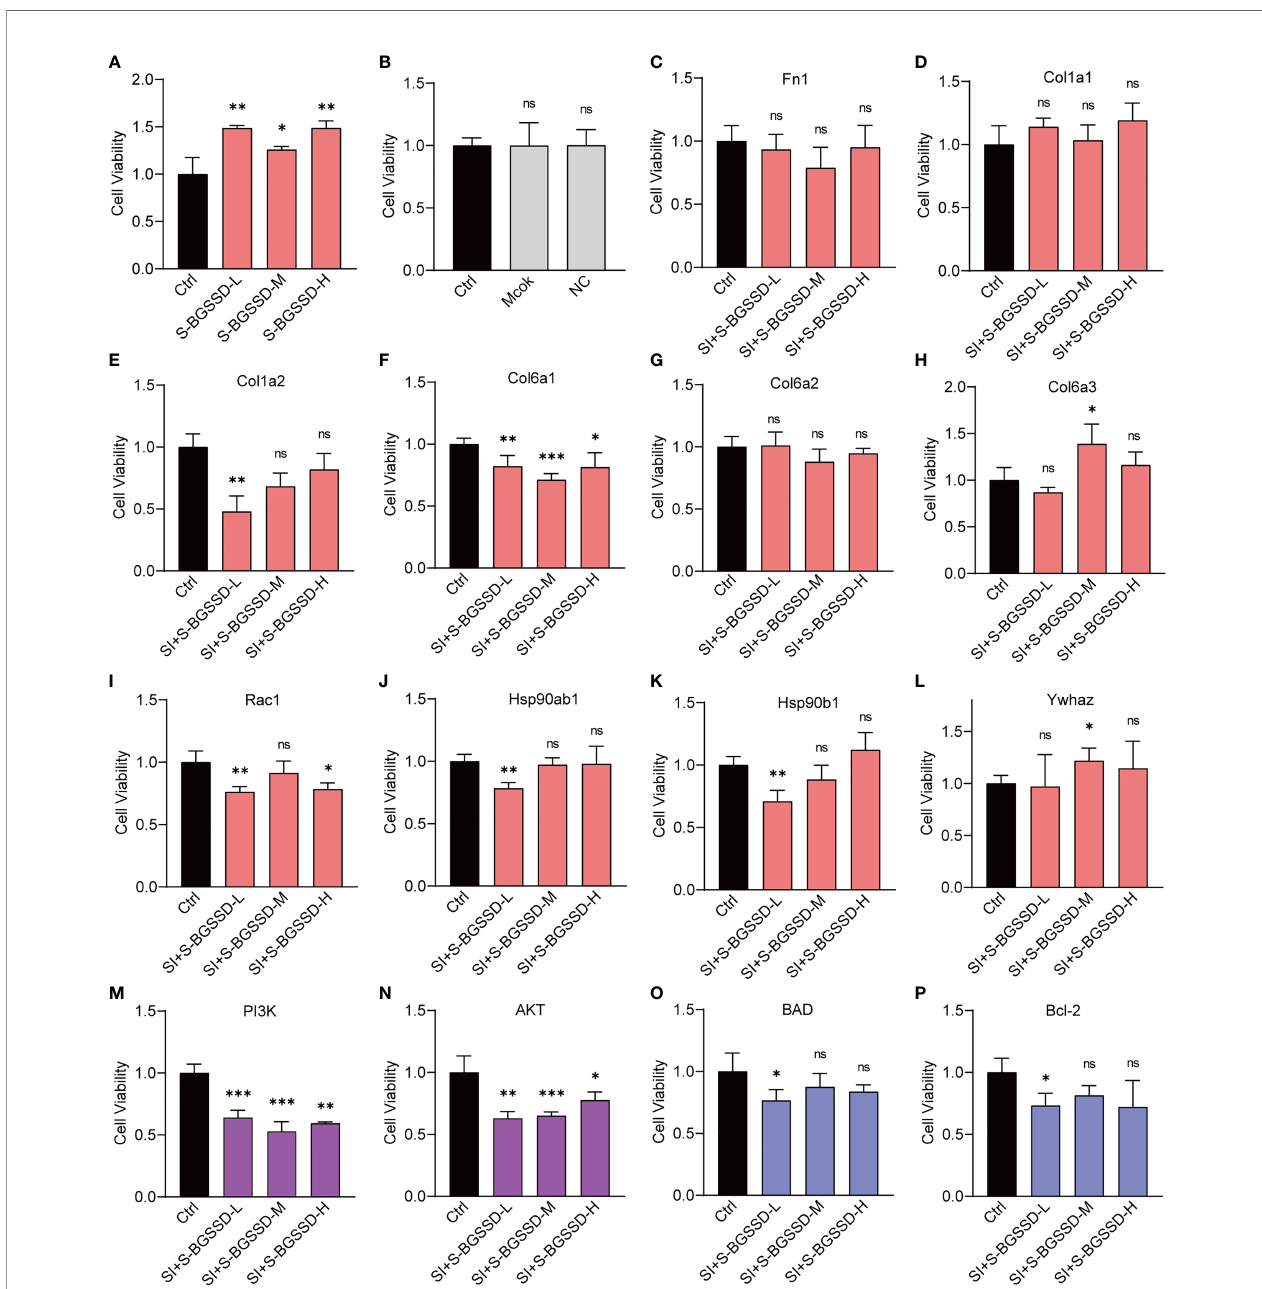
FIGURE 5 | RNA interference to verify the effects of targeting proteins of the PI3K-AKT pathway on the ef fi cacy of BGSSD. (A) BGSSD could promote the proliferation of MC3T3-E1 cells. (B) The solvent (Mock) and negative control (NC) of siRNA almost had no effect on the viability of MC3T3-E1 cells. (C – L) Knockdown of each of the ten targeted proteins (Fn1, Col1a1, Col1a2, Col6a1, Col6a2, Col6a3, Rac1, Hsp90ab1, Hsp90b1, and Ywhaz, except the Col6a3 and Ywhaz in the S- BGSSD-M group) by siRNA abolished the proliferation-promoting effect to various extents of BGSSD in MC3T3-E1 cells. (M – P) Knockdown of the proteins of PI3K- AKT and its downstream pathway, named PI3K, AKT, BAD, and Bcl-2, revoked the pro-proliferation effect of BGSSD. The pink columns represent the outcomes of targets obtained by quantitative proteomics. The purple columns refer to the proteins in the PI3K-AKT signaling pathway. The blue are proteins in the downstream pathway. Asterisks denote the comparison to serum-starved cells treated with rats ’ blank serum (Ctrl). All intervening times were 48 h. All data are presented as the mean± s.e.m., *p < 0.05, **p < 0.01, *** p < 0.001. NS, not statistically signi fi